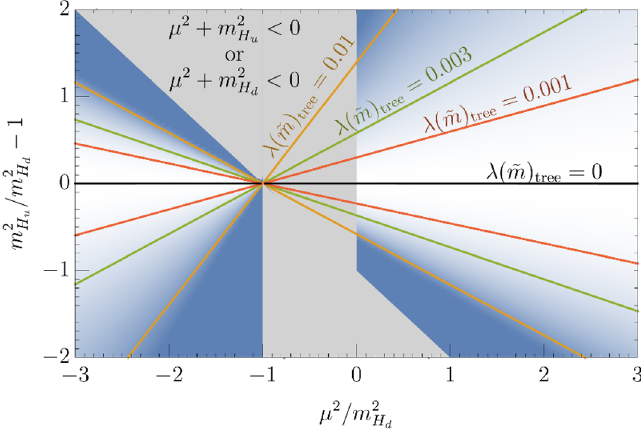
Figure 2 . Regions of parameter space showing the smallness of the ISS tree-level prediction for the Higgs quartic coupling at the scale ˜ m . λ ( ˜ m ) tree is less than 10 − 3 if µ is much greater than m H m H , or if m H and m H are nearly degenerate. The tree-level prediction is zero when m 2 u d d as indicated by the black horizontal line. In the gray region, one of the Higgs doublets has a negative mass squared. With Higgsino or sneutrino LSP, the blue region is excluded by